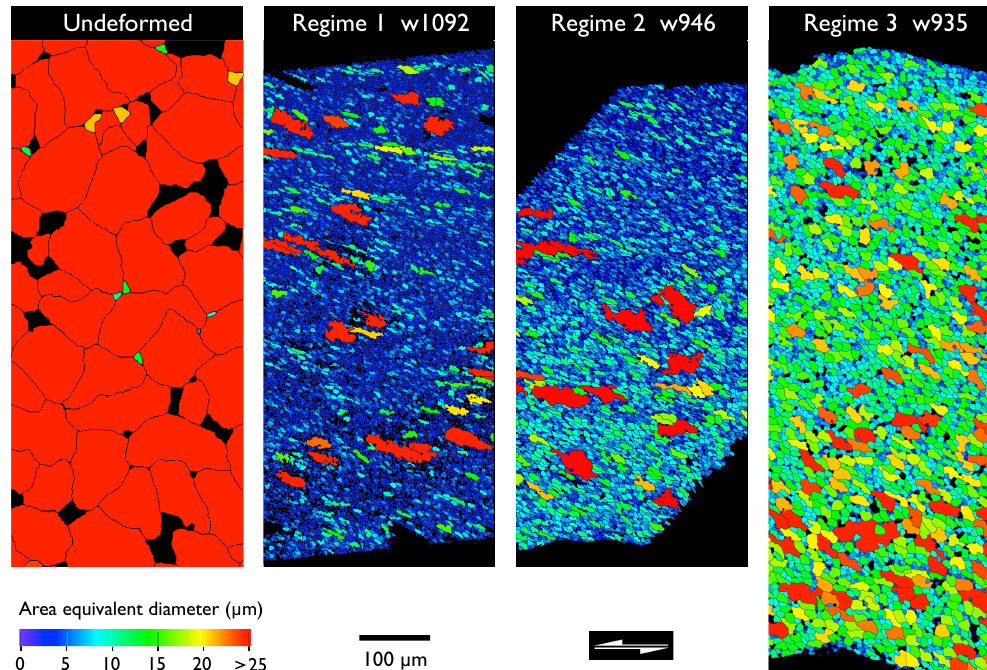
Figure 3. Grain size maps. Color-coded grain size maps visualizing the diameter of area equivalent circles. From left to right: for undeformed Black Hills Quartzite and samples deformed in regimes 1, 2, and 3. Scale, shear sense, and look-up table for grain size apply to all. Red indicates the diameter of an area equivalent circle d ≥ 25µm. Note that the diameter of undeformed Black Hills Quartzite is ∼ 100µm.